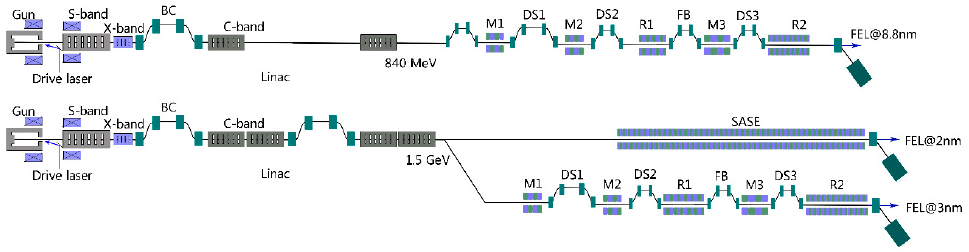
Figure 11. Schematic layouts: SXFEL-TF ( upper ) and Shanghai soft X-ray Free-Electron Laser User Facility (SXFEL-UF) ( lower ). Table 4. Main parameters of the SXFEL-UF.